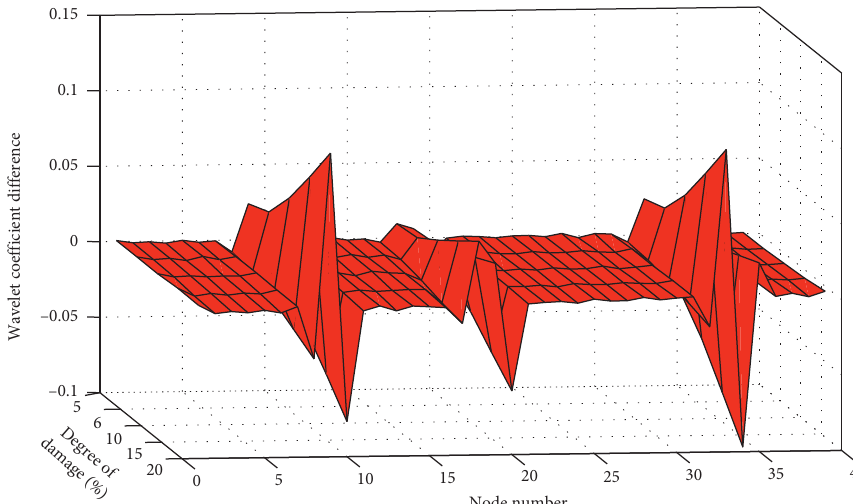
Figure 16: Three-dimensional surface of the wavelet coefficients of multiple points of damage in working condition